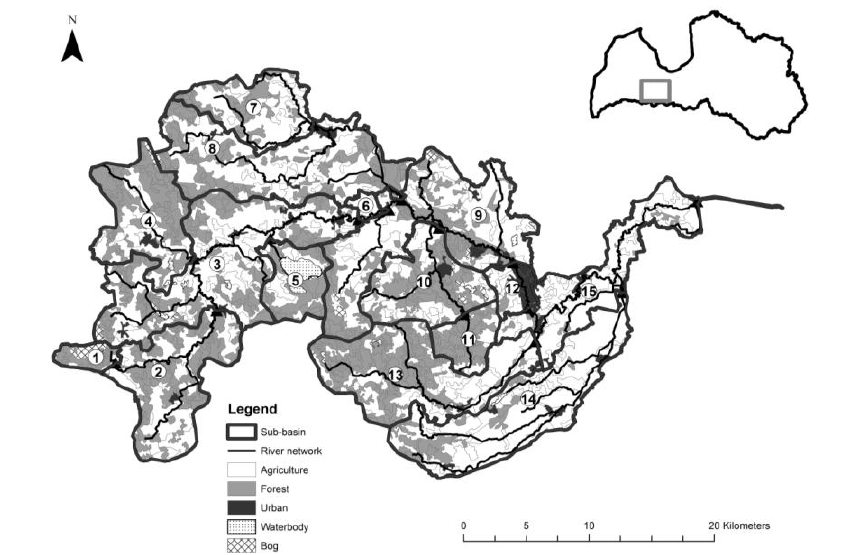
Fig. 1. The geographical location and land use of Berze River